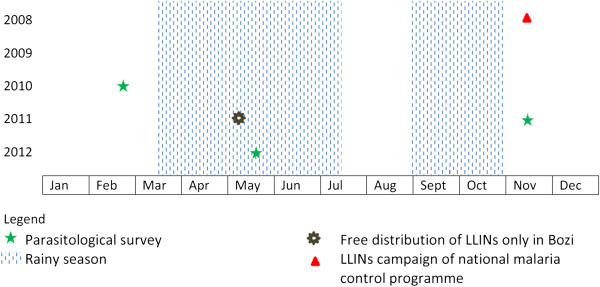
Study design and timing of parasitological survey and free distribution of LLINs from 2009 to 2012 in three rural communities of central Côte d’Ivoire.